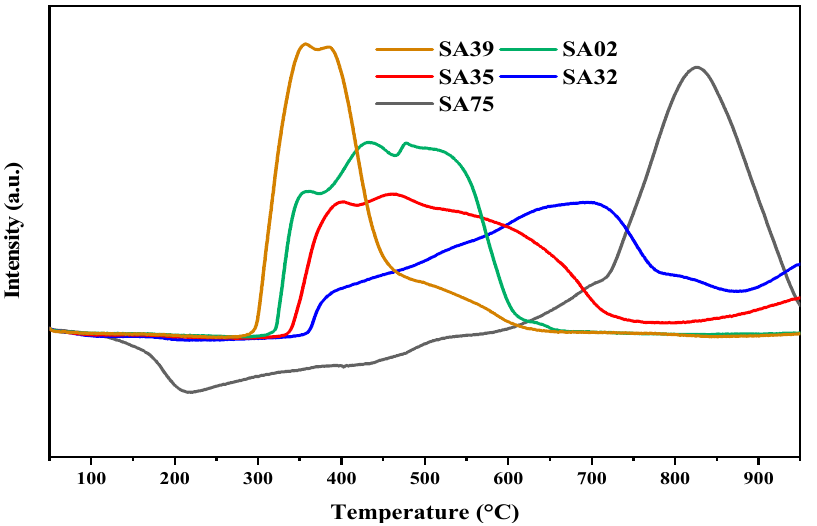
Figure 2. H 2 -TPR profiles of fresh Ni-supported catalysts.